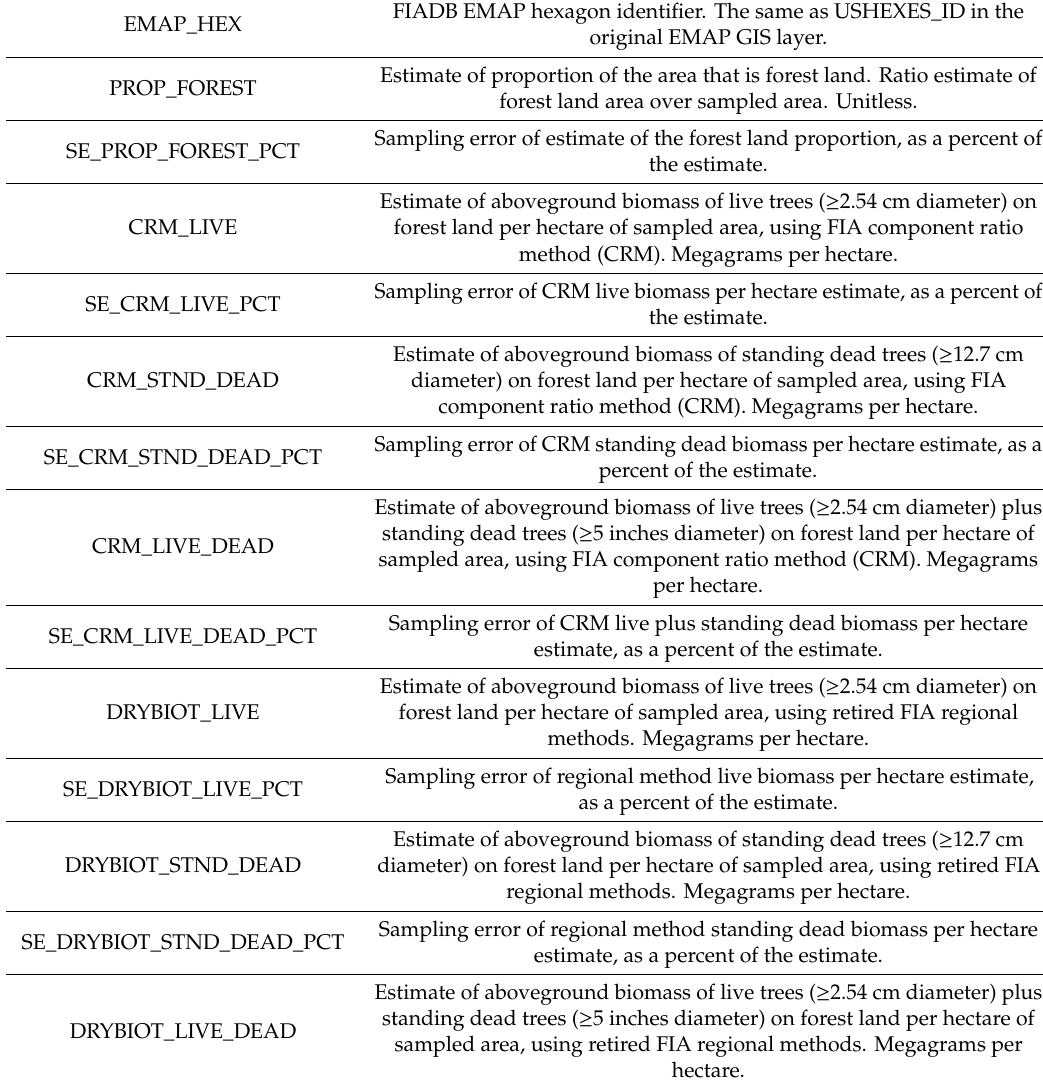
Table 1. Attributes estimated for each EMAP hex using the FIA